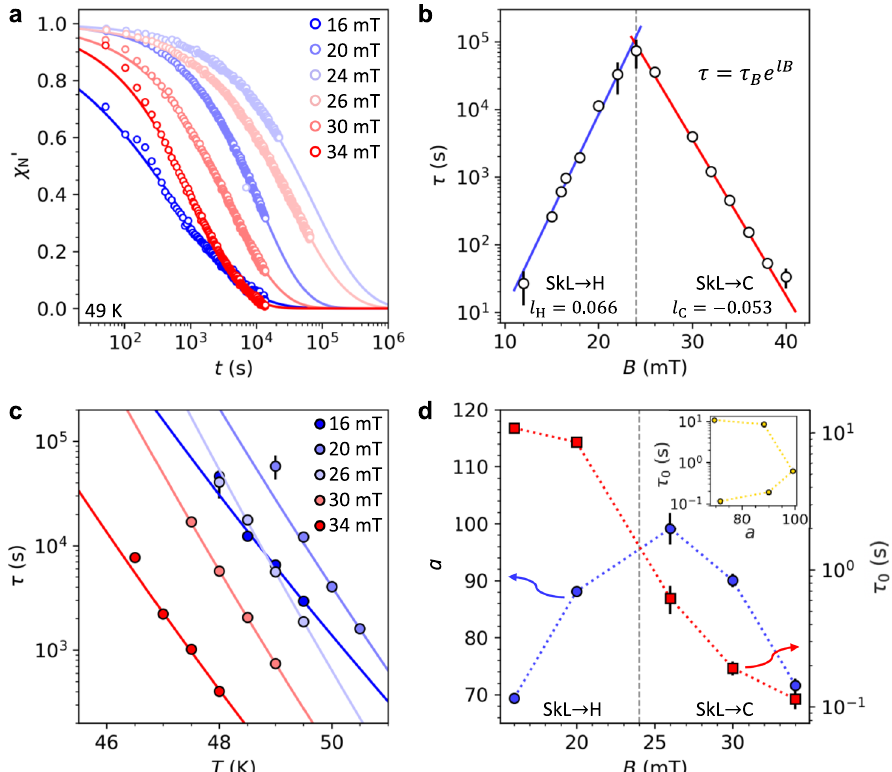
Fig. 3 Measuring fi eld-dependent skyrmion lifetimes. a The normalised real component of the AC susceptibility, χ 0 N , measured as a function of time at a range of applied magnetic fi elds after fi eld cooling the sample at 20 mT from 65 to 49 K. The data is fi tted with the stretched exponential decay function, and the corresponding magnetic fi elds are labelled. b The fi tted lifetimes are plotted as a function of the applied magnetic fi eld on a logarithmic axis. The two distinct exponential trends are fi tted to τ ¼ τ B exp ð lB Þ , where τ B is the lifetime at 0 mT, and l is the linear constant in the exponent, to determine how the lifetime varies with the applied fi eld. The extracted parameters for l are 0.066 and − 0.053 mT − 1 for the suggested skyrmion lattice to helical (SkL → H) and skyrmion to conical (SkL → C) ranges respectively. c Further lifetimes measured at different fi elds are plotted as a function of temperature. The datasets are fi tted with a modi fi ed Arrhenius law to extract a and τ 0 . d The value of a and τ 0 are plotted as a function of the applied fi eld. In the inset, the determined τ 0 and a parameters are plotted against one another to test the Meyer-Neldel compensation rule. All error bars indicate the standard error obtained when fi tting the data to the relevant